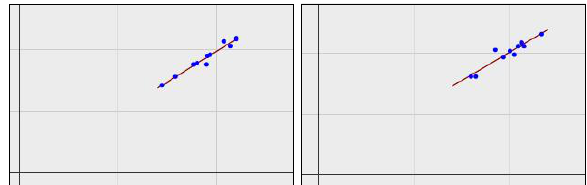
Figure 12. Linear regression graph for MD (left) and VL (right) measurements.